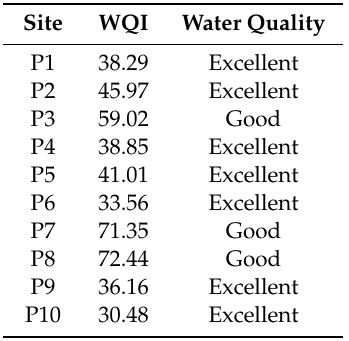
Table 11. Water Quality Index in the urban zone of Zamora,